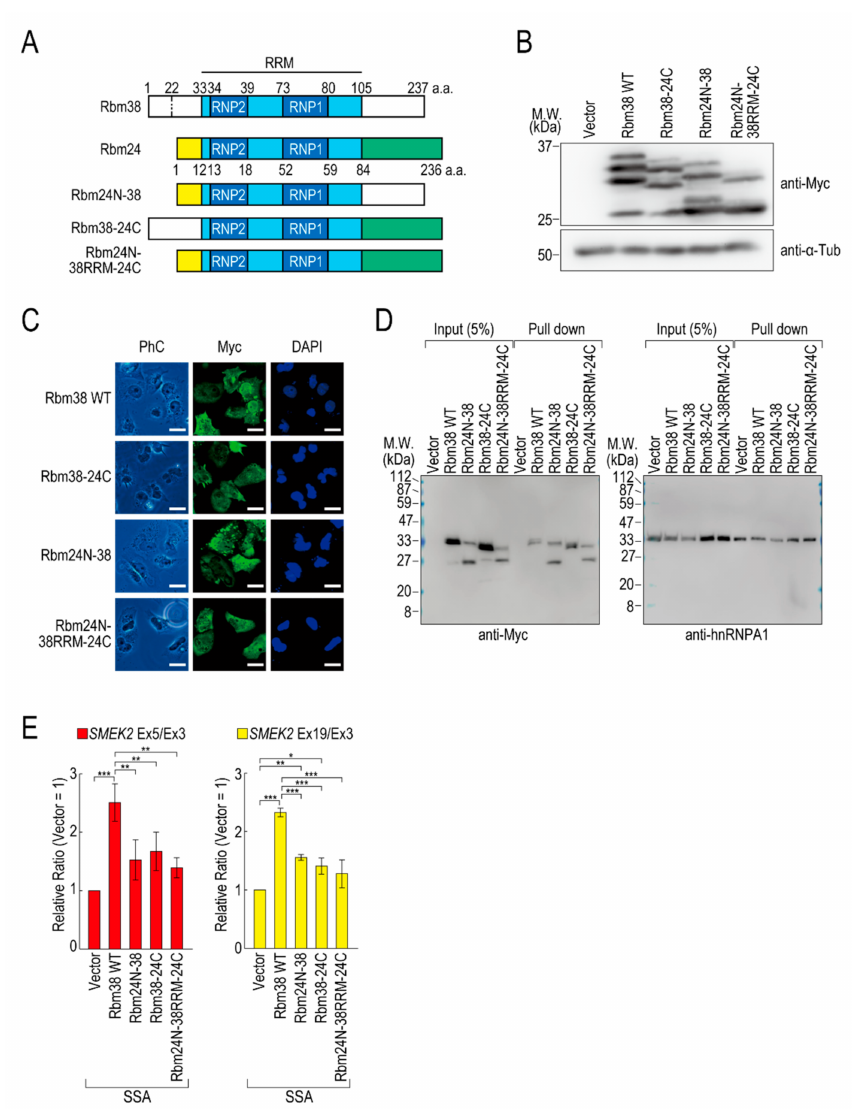
Figure 3. The N- and C-terminal regions of Rbm38 are important for reducing the transcription elongation defect. ( A ) A schematic of the structure of chimeric RNA binding proteins. ( B , C ) HeLa cells were transfected with a vector or chimeric plasmids, and then cultured for 48 h after transfection. Protein samples were prepared and analysed by Western blotting ( B ). The subcellular localization of chimeric proteins was analysed by immunofluorescence microscopy ( C ). Bar = 20 µ m. ( D ) A biotinylated RNA pull-down assay was performed using chimeric proteins as in Figure 2C. ( E ) HeLa cells were transfected with a vector or chimeric constructs, and then treated with SSA and 5-EU. The labeled RNA was analysed as in Figure 1. Error bars indicate S.D. ( n = 3). Statistical significance was investigated by one-way ANOVA and Tukey’s test (*: p < 0.05; **: p < 0.01; ***: p <